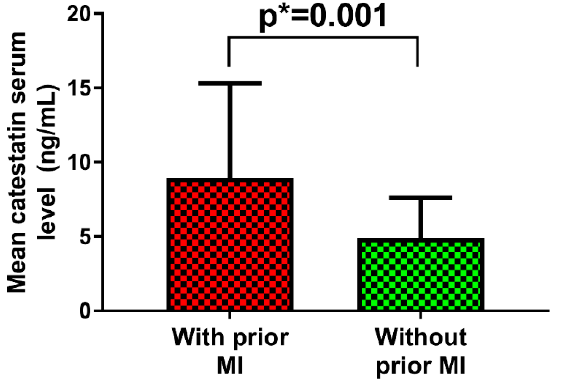
Figure 2. Catestatin (CST) serum levels in acutely decompensated heart failure patients stratified by the previous history of acute myocardial infarction.